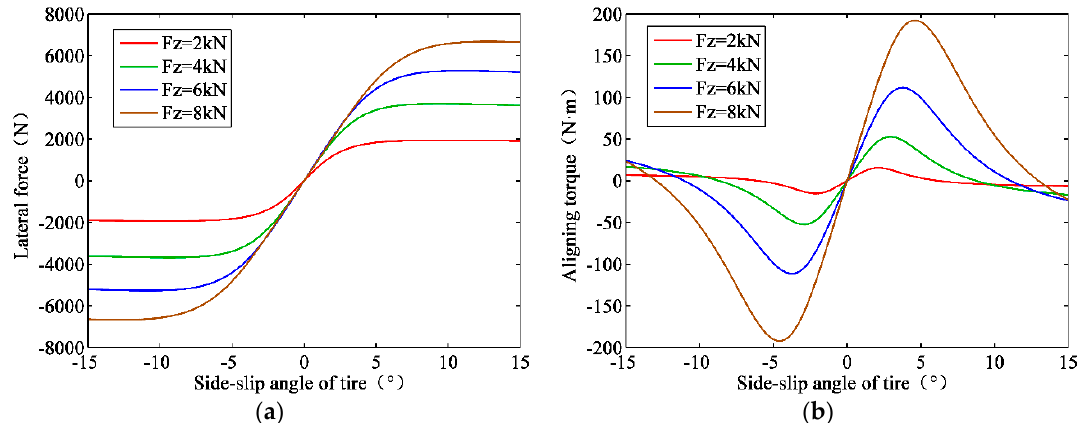
Figure 7. The relation curves obtained by ‘Magic Formula’: ( a ) The lateral force with the side-slip angle of tire; and ( b ) the aligning torque with the side-slip angle of tire.